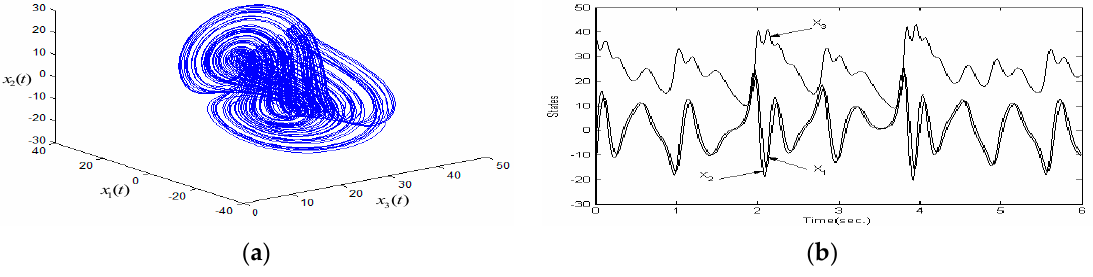
Figure 3. ( a ) The deterministic chaotic attractor of Chen’s system, plotted in the x 3 − x 1 − x 2 space; ( b ) the deterministic chaotic time series of Chen’s system.